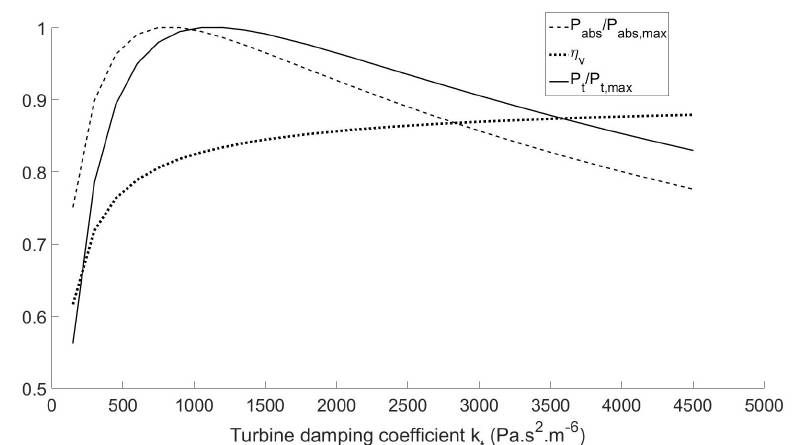
Figure 18. Parametric study of the turbine damping coefficient to maximise pneumatic power made available to the